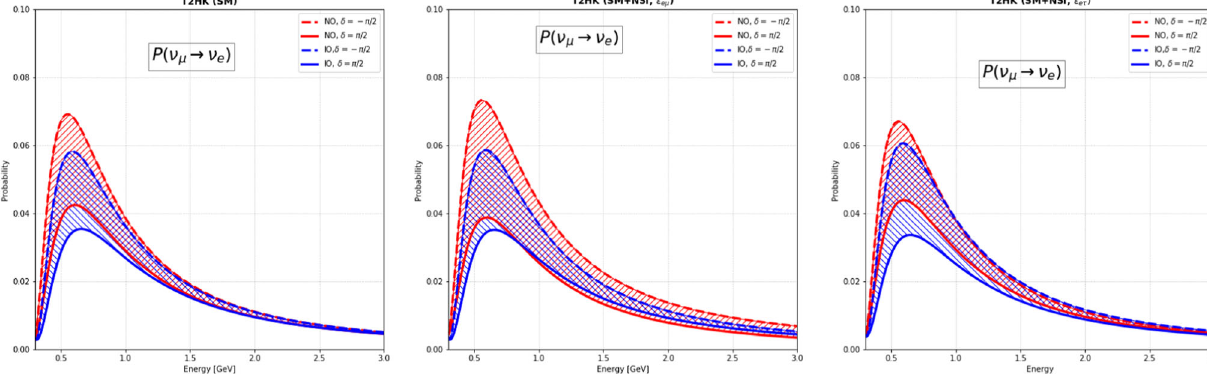
Fig. 7 Probability plots for T2HK in SM (left) and SM+NSI scenario with NSI arising from e − μ sector (middle) and e − τ sector